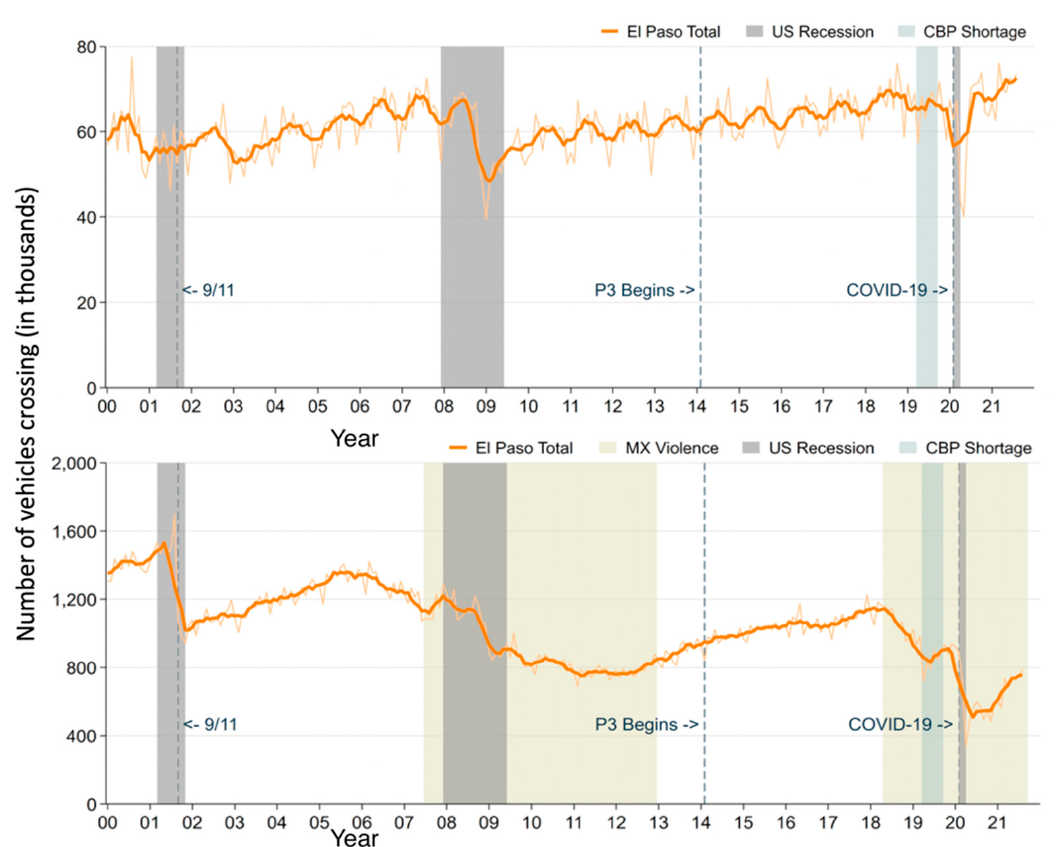
Figure 3. Cargo trucks ( top ) and personal vehicles ( bottom ) crossing the EPJ international borders in thousands in last two decades. A significant drop in both the commercial and private vehicles can be seen in 2008–2009 and 2020. Source: